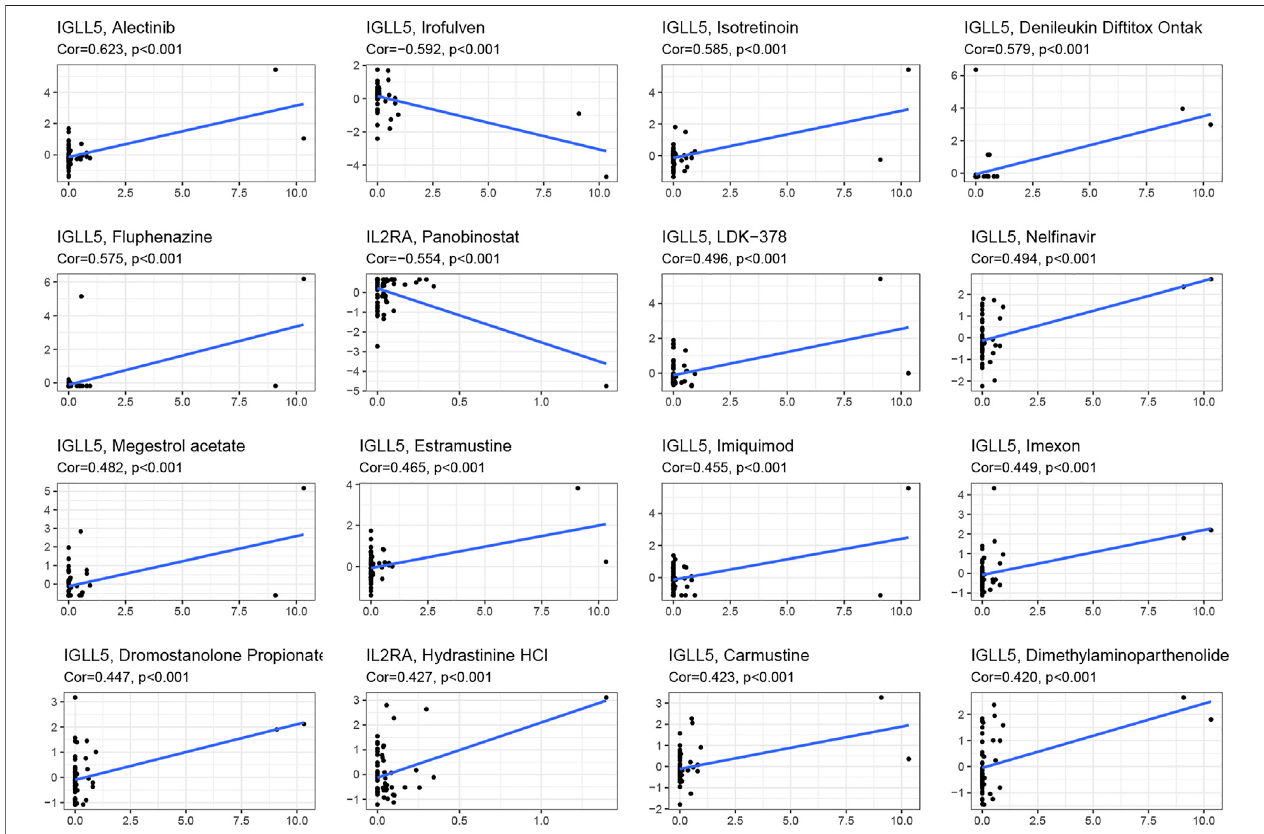
FIGURE 7 | The Prediction analysis between IGLL5 and IL2RA and drug